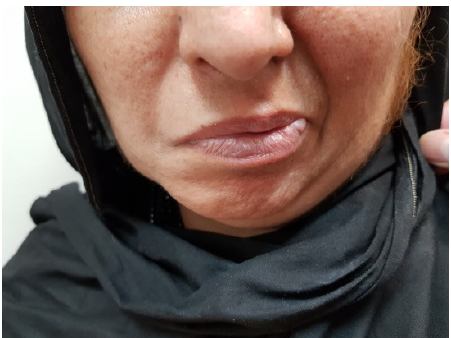
Figure 2. Facial nerve palsy induced by TAC. Drooping at the right corner of mouth and loss of right nasolabial fold are shown. The patient had only lower facial nerve involvement and upper face features were normal.